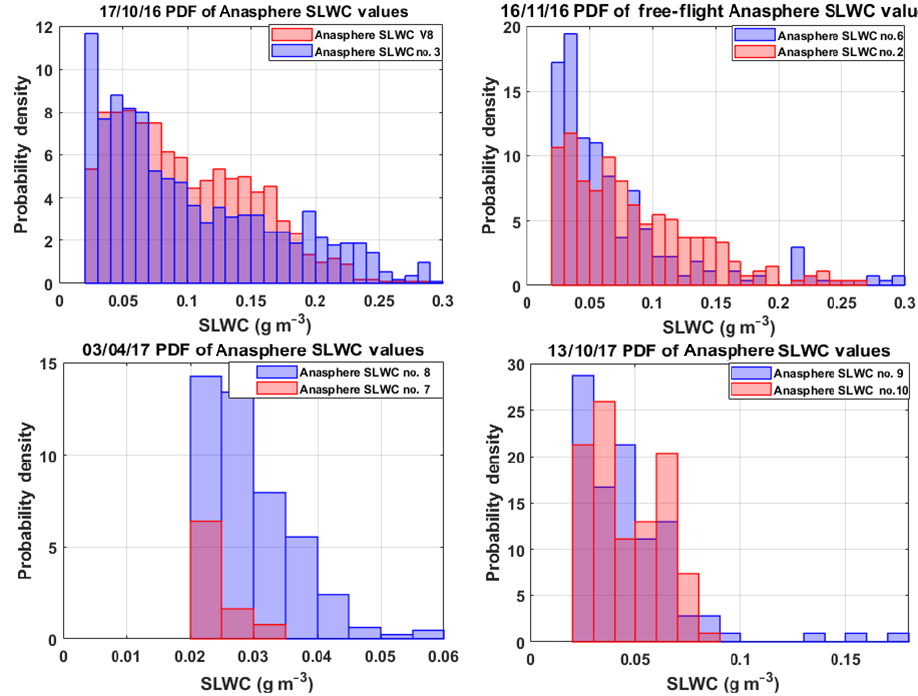
Figure 4. Probability density functions (PDFs) of four side-by-side comparison flights of Anasphere SLWC sondes.